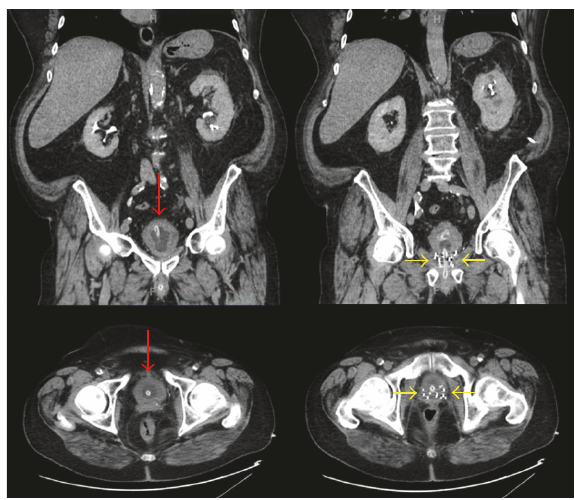
Figure 1: Computed tomography (CT) scan of the abdomen and pelvis revealed diffuse thickening of the wall of the urinary bladder with intravesical catheter (red arrows) and brachytherapy radiation seeds in the prostate (yellow arrows)